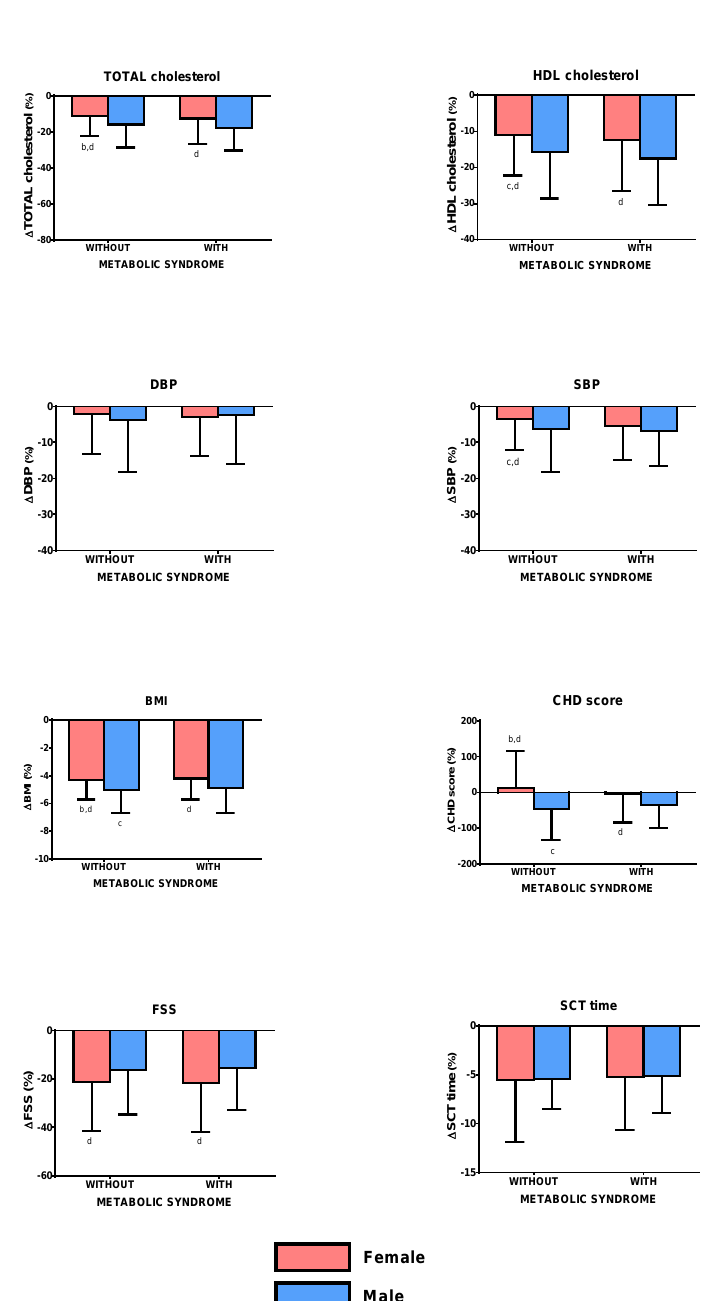
Figure 1. Changes of total cholesterol, HDL cholesterol, diastolic blood pressure (DBP), systolic blood pressure (SBP), body mass index (BMI), coronary heart disease (CHD) score, fatigue severity score (FSS), and stair-climbing test (SCT) time, before and after a three-week body weight reduction program (BWRP) in obese subjects with or without metabolic syndrome, subdivided for sex (females/males). Data are expressed as mean ± SD. All parameters were compared among all subgroups (females/males and with/without metabolic syndrome) by using a two-way ANOVA, followed by post hoc Bonferroni’s test. b : 0.05 vs obese males without metabolic syndrome; c : p < 0.05 vs obese females with metabolic syndrome; d : p < 0.05 vs obese males with metabolic syndrome. In order to facilitate the interpretation of multiple comparisons, please, note that the four boxes (1, 2, 3, and 4) of each panel may be named as “a”, “b”, “c”, and “d” from the left side to the right one. Therefore, when the symbol of significance is indicated under a box (e.g., “c” under Box 2), this means that the comparison between the two boxes (i.e., Boxes 2 and 3) is statistically significant.